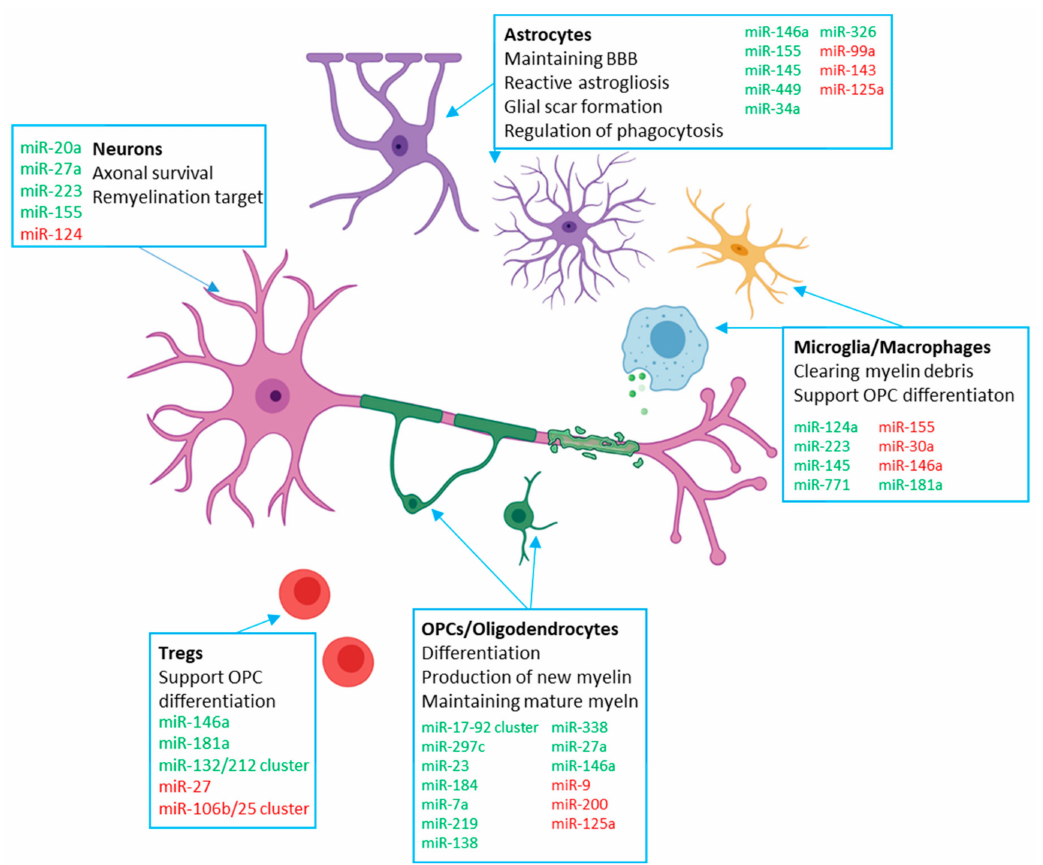
Figure 1. Schematic of key cells involved in remyelination and relevant miRNAs that regulate the process. miRNAs and miRNA clusters that are broadly positive regulators of remyelination are listed in green, and those that are broadly negative regulators of remyelination are listed in red (created with